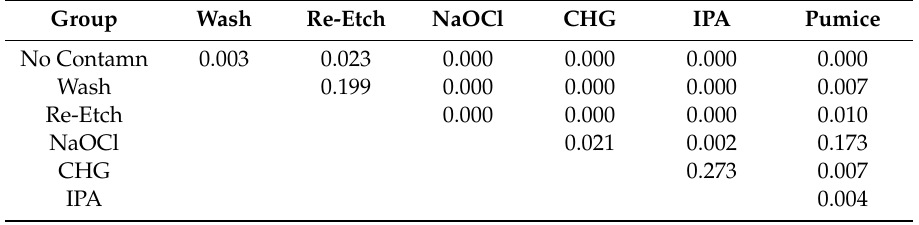
Table 5. Mann–Whitney post-hoc comparison between the SBS recorded in self-etch groups.